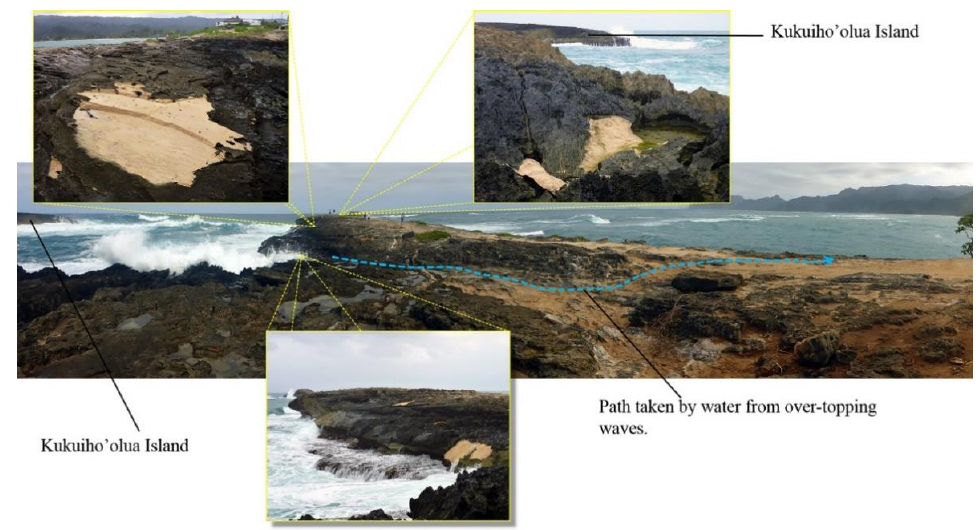
Figure 4. Examples of fresh sandstone surfaces (light-colored) exposed by removal of rock by extreme, ENSO-induced waves at Laie Point on 24–25 February 2016. View of center image is looking east. Compare to Figure 5.